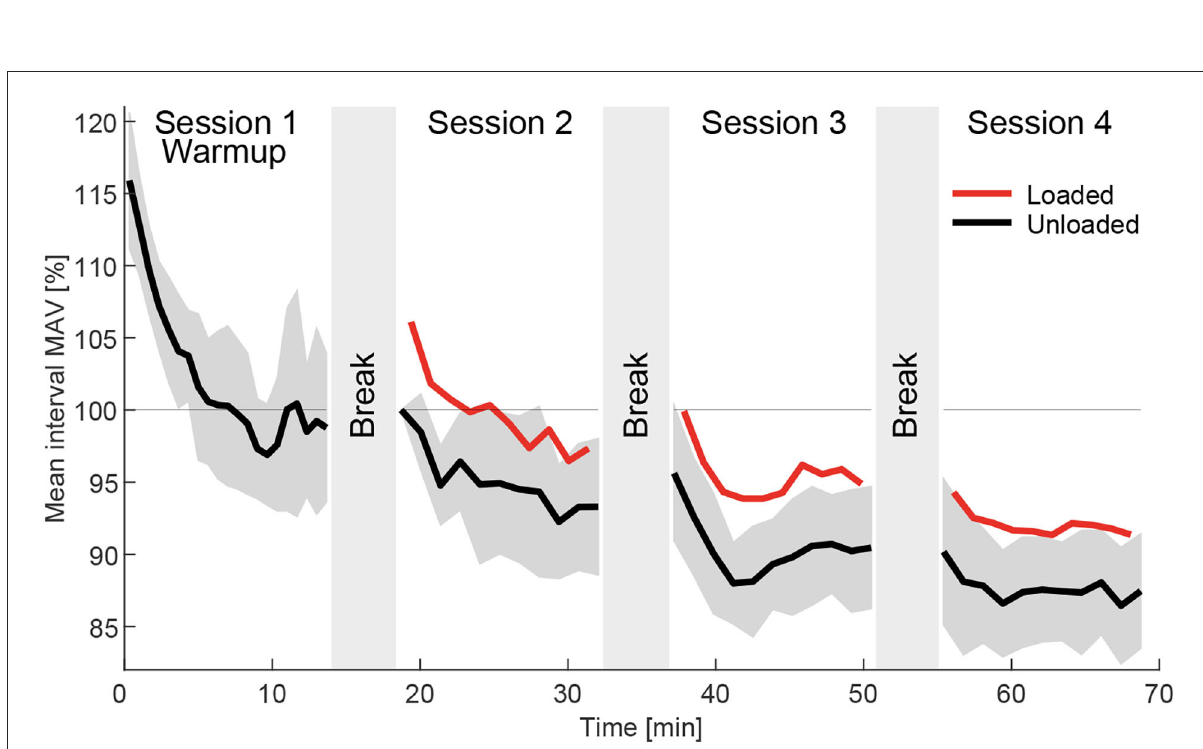
FIGURE12 Grand mean interval MAV (MAV int ) for the loaded (red) and unloaded (black) condition in the order they were performed during the experiment, which included four sessions beginning with the Warmup followed by the three weight sessions in randomized order. The data includes the strides of all subjects and muscles of both limbs without transition and offset strides. The data was normalized to the MAV int of the first interval of session 2. The standard deviation of the 14 muscles of the unloaded data MAV intstd is indicated in dark gray. Average break times in between sessions were determined and indicated by the gray areas in between sessions. A clear negative drift of the MAV int was found over